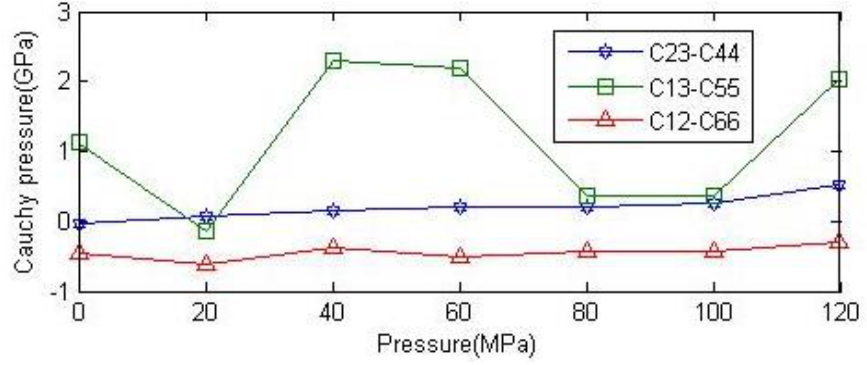
Figure 6. Relationship between Cauchy pressure of anhydrite crystals and ambient pressure.